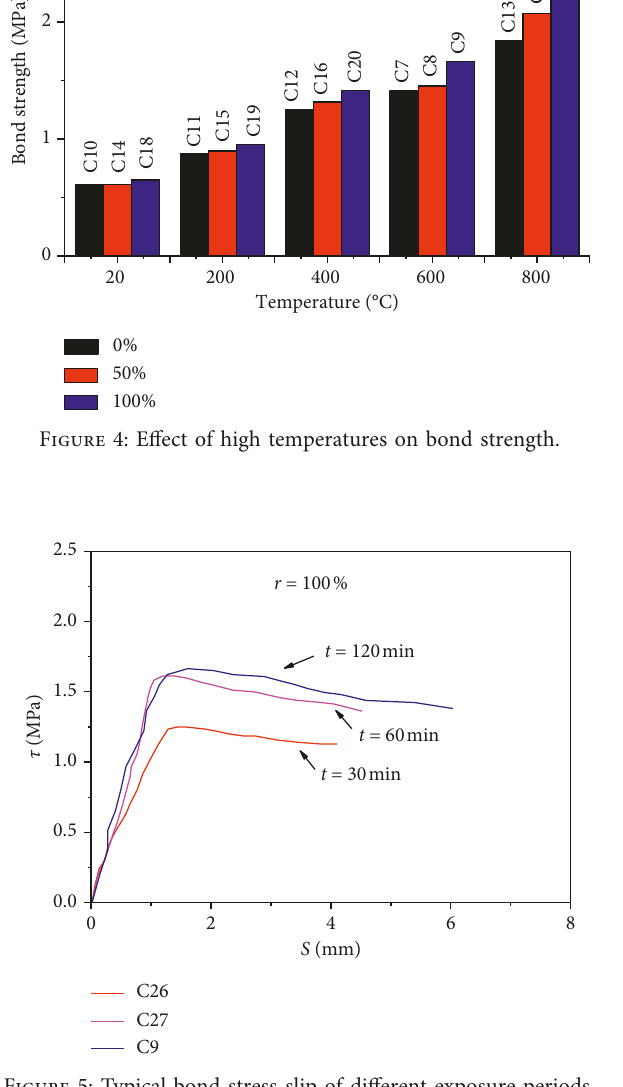
Figure 5: Typical bond stress-slip of different exposure periods. Figure 7: Typical bond stress-slip for different RCA replacement